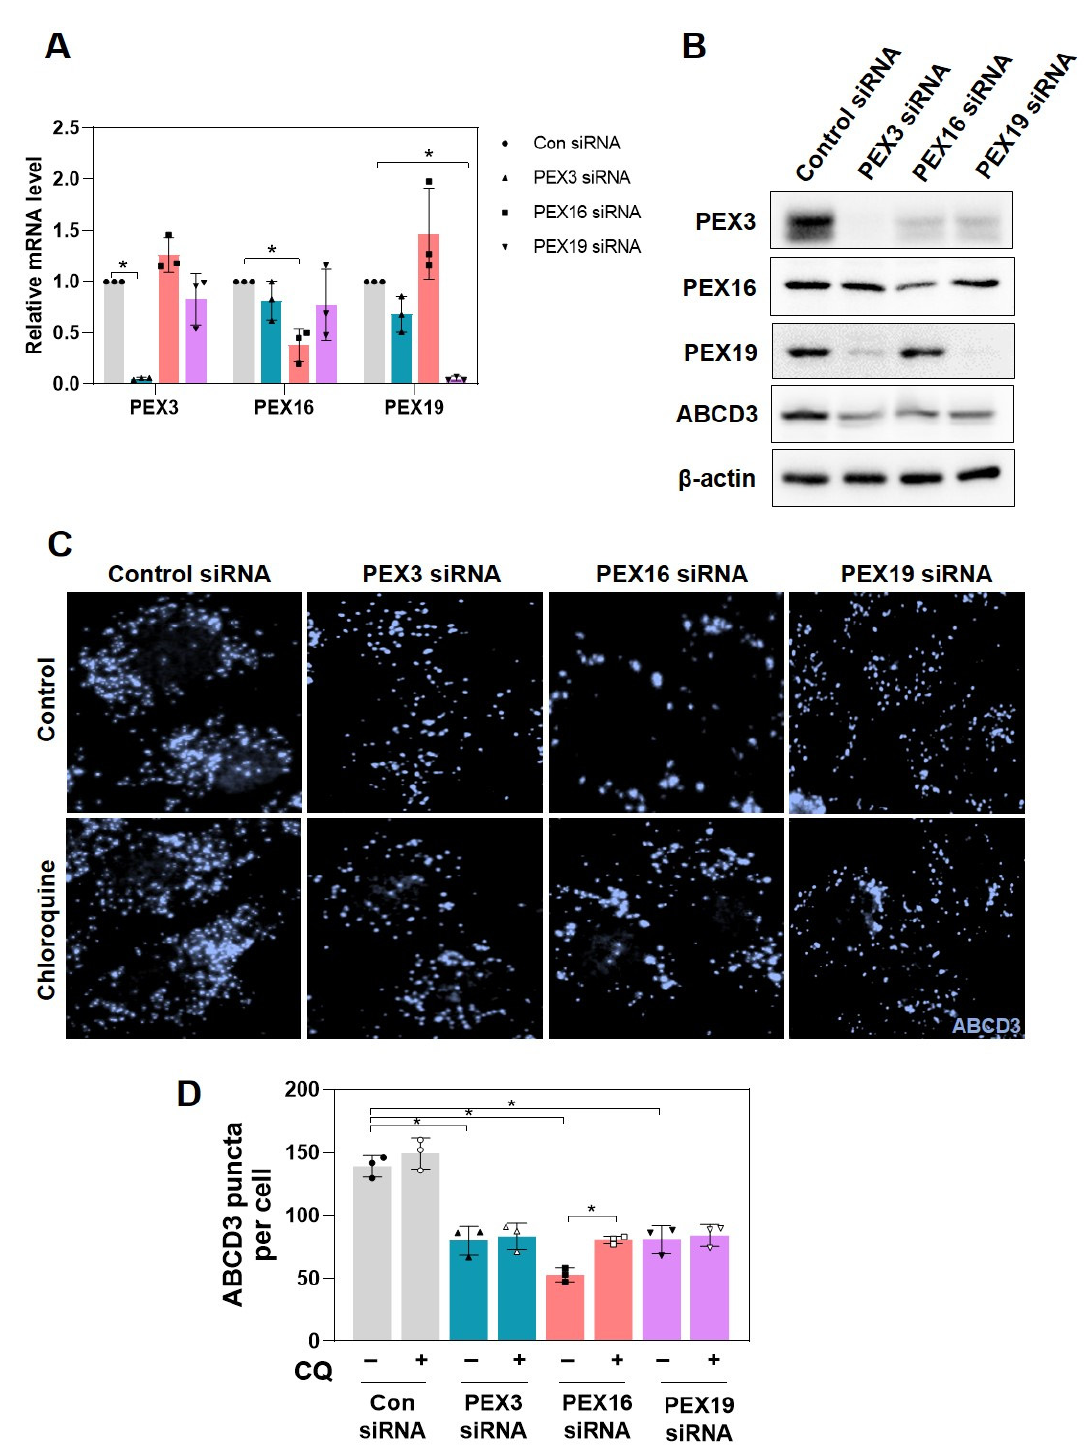
Figure 1. Knockdown of PEX3, PEX16, and PEX19 decreases peroxisome abundance in RPE-1 cells. RPE-1 cells were transfected with siRNA of PEX3, PEX16, and PEX19 for 72 h. The transfection efficiency was evaluated by measuring ( A ) the relative mRNA levels with RT-qPCR and ( B ) the protein expression by immunoblotting. ( C ) Cells were treated with siRNA of PEX3, PEX16, and PEX19 for 48 h and treated with 5 µ M chloroquine (CQ) for an additional 24 h. Cells were subjected to immunofluorescence to examine the expression of ABCD3 puncta. ( D ) Quantification of ABCD3 puncta represented the number of peroxisomes per cell. Data are expressed as means ± S.D. ( n = 3, independent experiments), * p < 0.05.